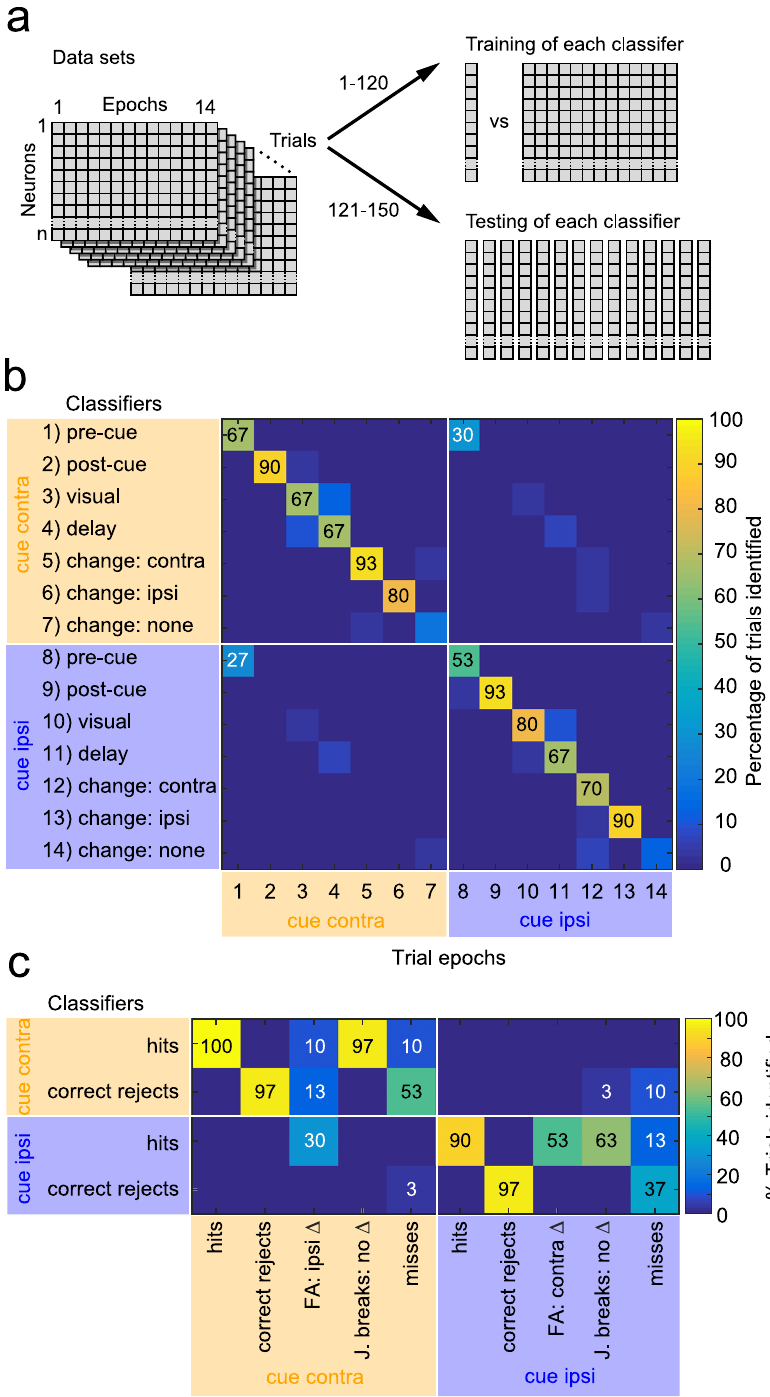
Fig 7. Linear classifier performance for the covert attention task. (A) Cartoon illustrating how the linear binary classifiers were trained and tested. Each single-trial data set was generated by random draws of spike counts from each neuron for each of the 14 epochs. For training of each classifier, trials 1–120 of these data sets were used to construct a classifier that could distinguish between data from its own epoch and data pooled across the other 13 epochs. For testing of each classifier, trials 121–150 were used to test and cross-validate the classifier with data from its own epoch individually and also to test how frequently it incorrectly recognized each of the other 13 epochs individually.